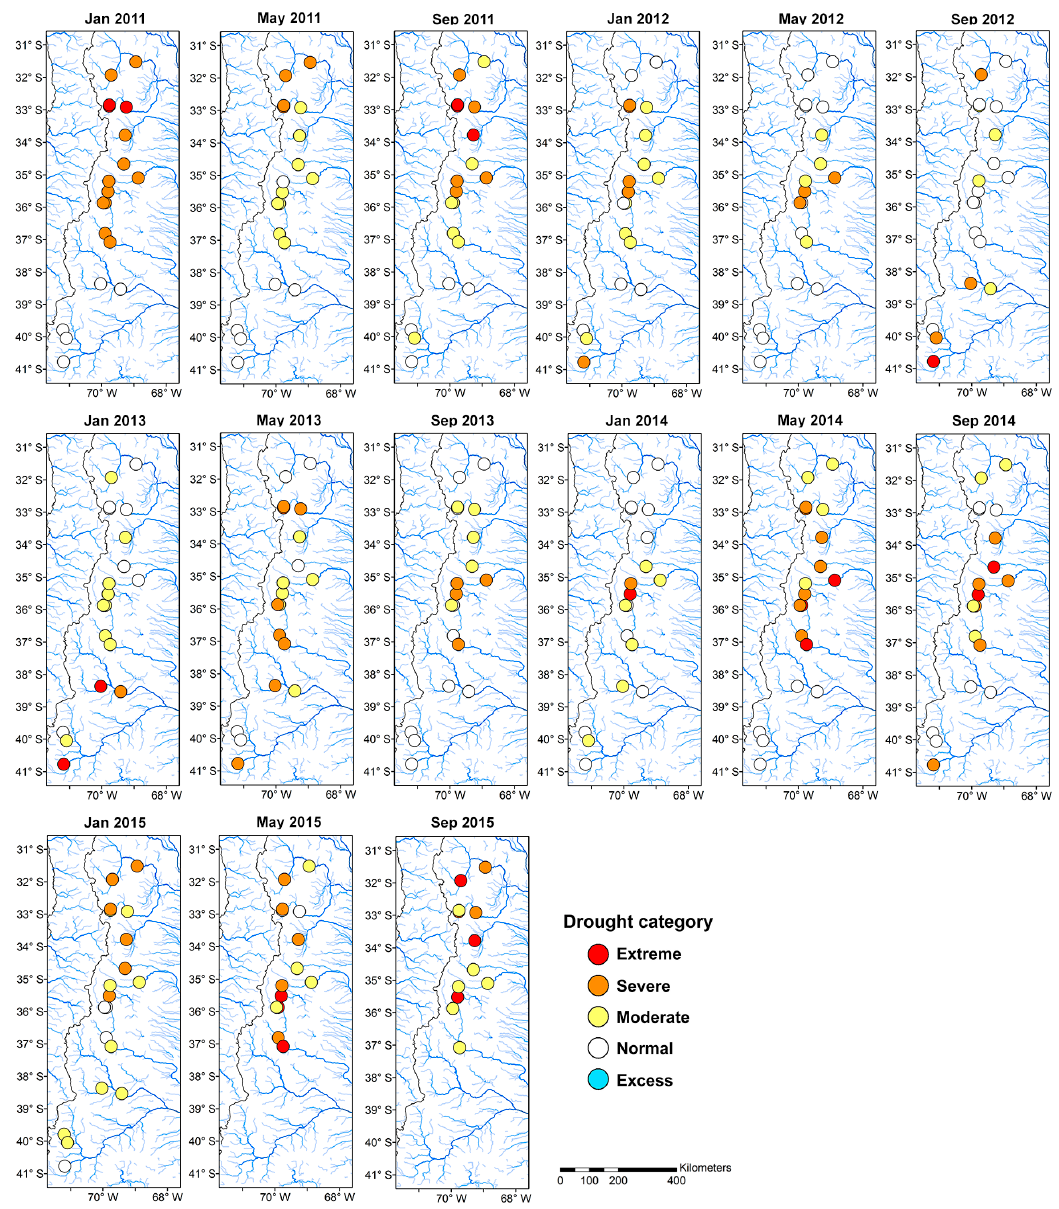
Figure 8. Spatial distribution of hydrological droughts by categories during January, May and September from 2011 to 2015.